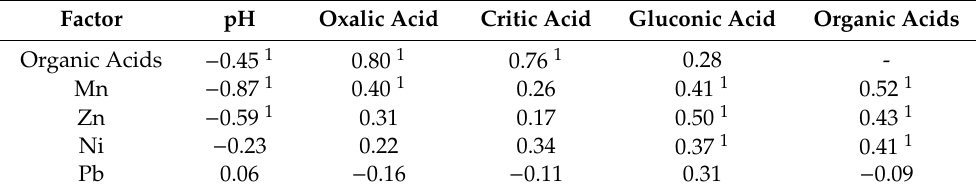
Table 2. Correlation coe ffi cients between metal removal e ffi ciency and organic acids.